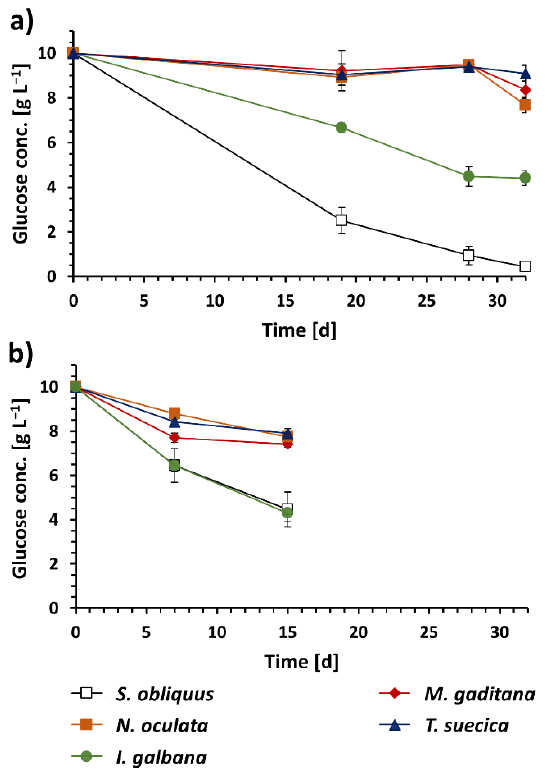
Figure 2. Glucose consumption monitored in ( a ) mixotrophic and ( b ) heterotrophic cultures. Error bars represent mean values ± standard deviation (n = 6).